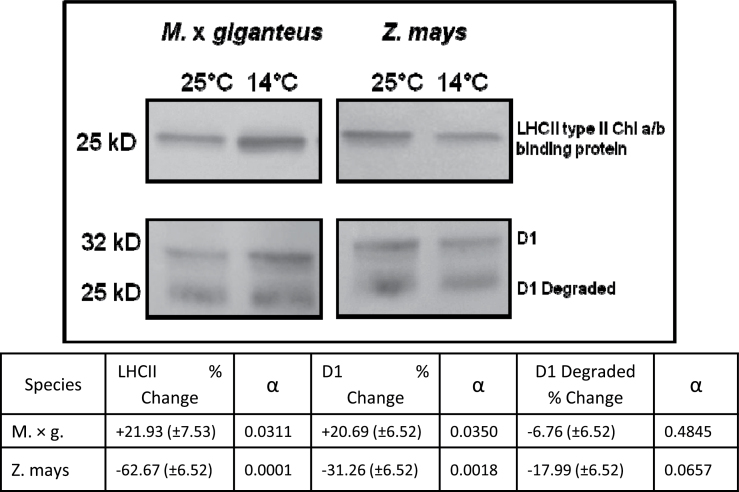
Representative Western blot images showing changes in LHCII type II chlorophyll a/b-binding protein, D1 protein, and D1 degradation products after 14 days of chilling (14 °C) compared to control (25 °C) in M. × giganteus and Z. mays. The same leaves as for Fig. 4 were used. Values are mean±SE for all biological samples. Differences between control and chilling were assessed by Student’s t-test (α≤0.05, n=4).